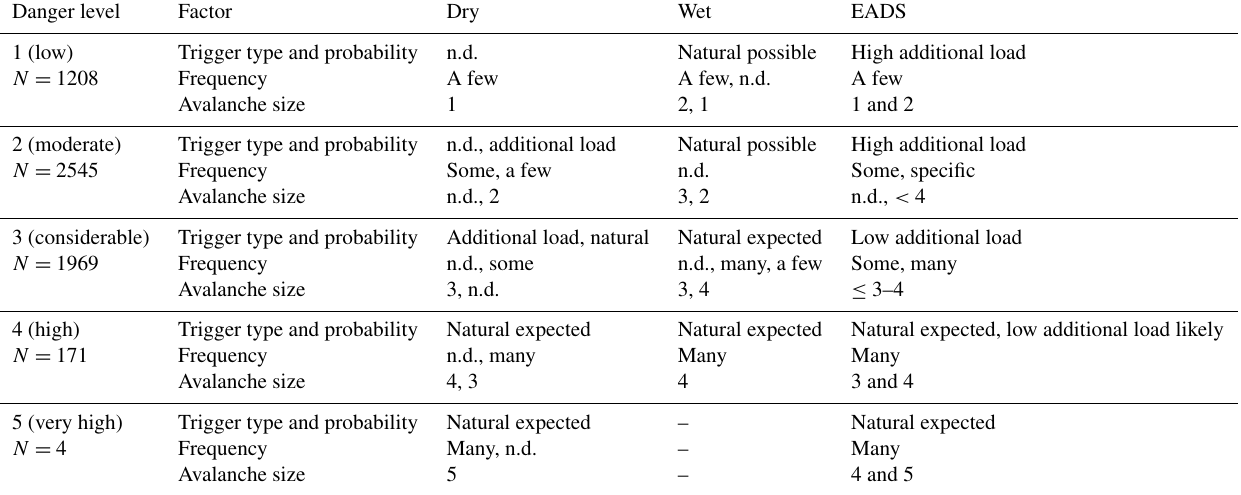
Table 6. Description of the contributing factors of avalanche danger for dry-snow and for wet-snow conditions and – as comparison – in the European Avalanche Danger Scale (EADS; extracted from Table 2; EAWS, 2021a). Results from this study are summarized by showing the list of the most frequent terms ordered according to their frequency of occurrence and if more than 20% of the time. The words in the EADS are translated according to the annotation in Tables A2–A4 and the overview by Müller et al. (2016); n.d. indicates that a key factor was not described in the danger descriptions or the EADS. If n.d. is listed first, this means that this key factor was more often not described compared to the most frequent label which was described; “–”: no data for wet-snow conditions at level 5 (very high). Danger level Factor Dry Wet EADS Natural